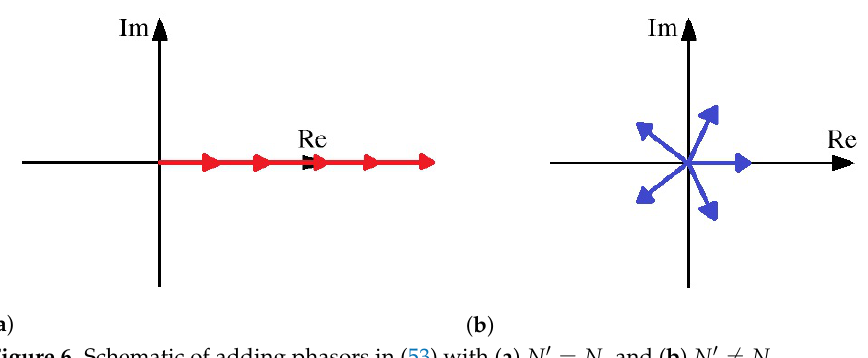
Figure 6. Schematic of adding phasors in (53) with ( a ) N (cid:48) s = N s and ( b ) N (cid:48) s (cid:54) = N s